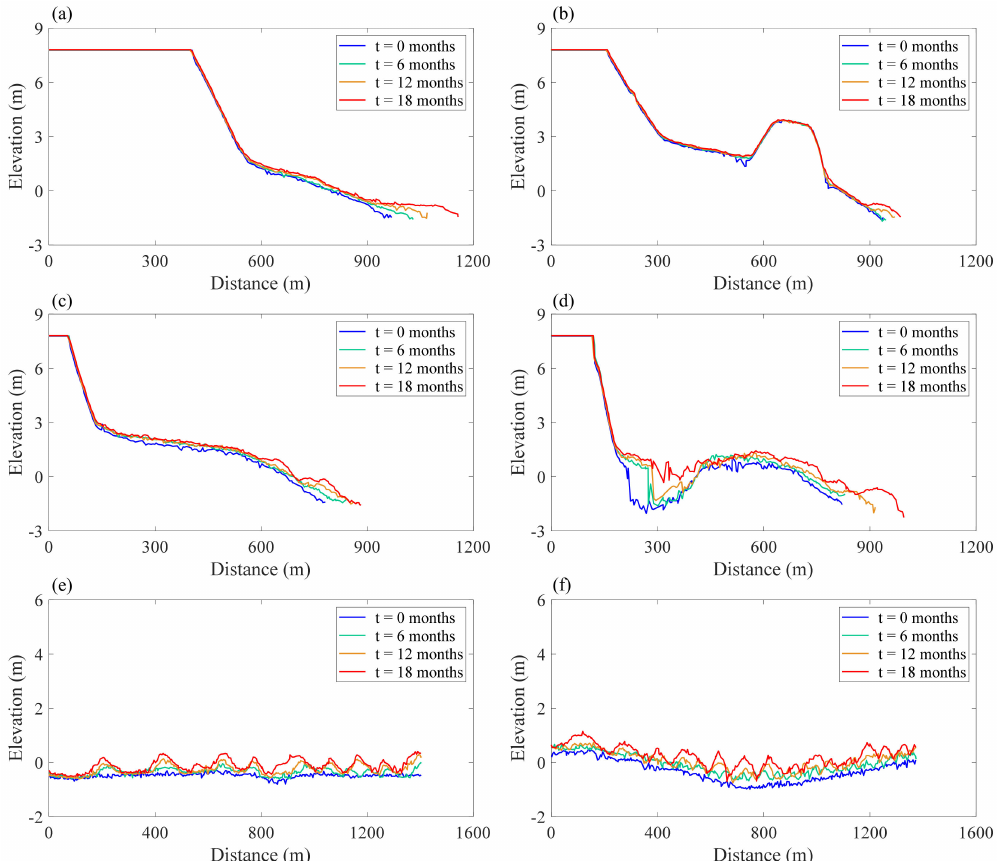
Figure 12. Elevation changes across ( a ) T1, ( b ) T2, ( c ) T3, ( d ) T4, ( e ) T5, and ( f ) T6. Positions of the cross-profile transects T1, T2, T3, T4, T5, and T6 are marked by dashed lines in Figure